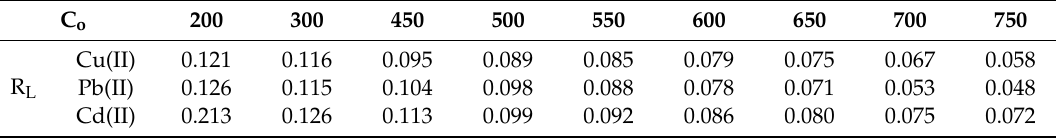
Table 5. R L values for Cu(II), Pb(II), and Cd(II) adsorption obtained from the Langmuir model. C o